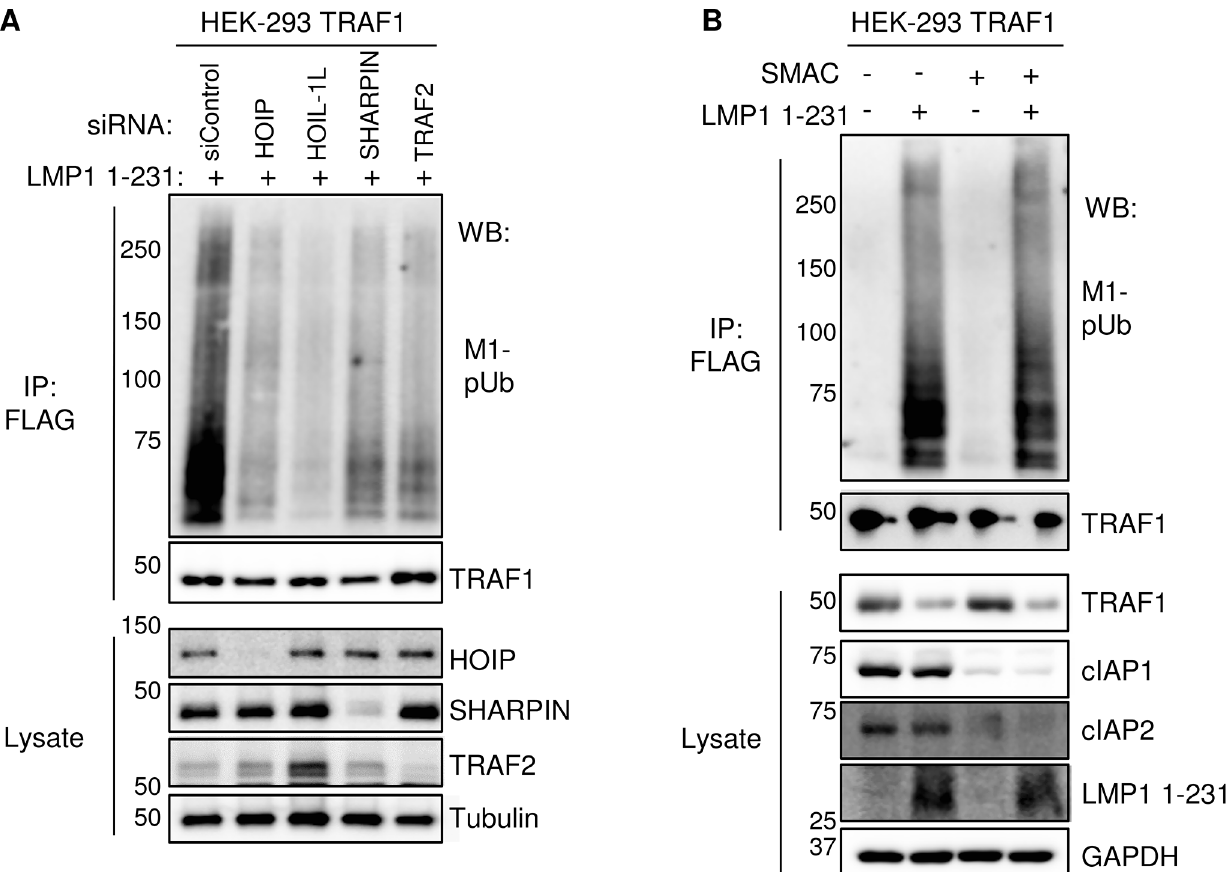
Fig 6. TRAF2, HOIP, HOIL-1L, and SHARPIN, but not cIAP1/2, are important for LMP1 1-231-induced M1-pUb chain attachment to TRAF1 complexes. A) 72 hours after siRNA transfection of 293 TRAF1 cells, LMP1 1 – 231 expression was induced for 16 hours. FLAG-TRAF1 complexes and lysates were WB, as indicated. B) 293 TRAF1 cells were treated with a SMAC mimetic peptide to deplete cells of cIAP ligases, and were then induced for LMP1 1 – 231 expression in the presence of the SMAC mimetic, as indicated. FLAG-TRAF1 IPs and lysates were blotted as indicated. A-B are representative of three independent